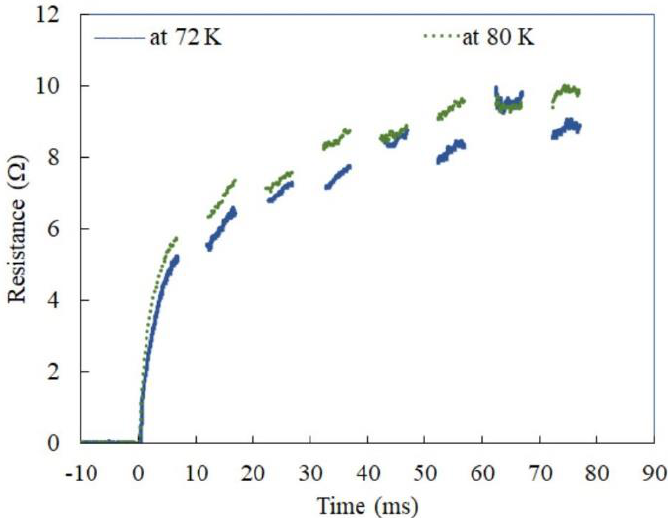
Figure 10. Comparison of SFCL resistance during fault at 72 K and at 80 K.